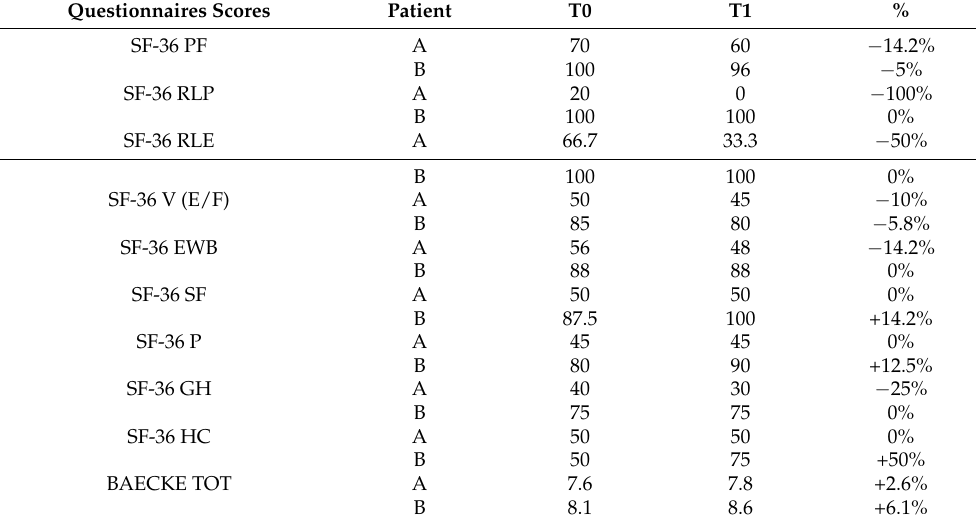
Table 5. Patient A and B Questionnaires scores before (T0) and after (T1) interventions. The compar- isons between pre- and post-intervention data are expressed by the percentage variation